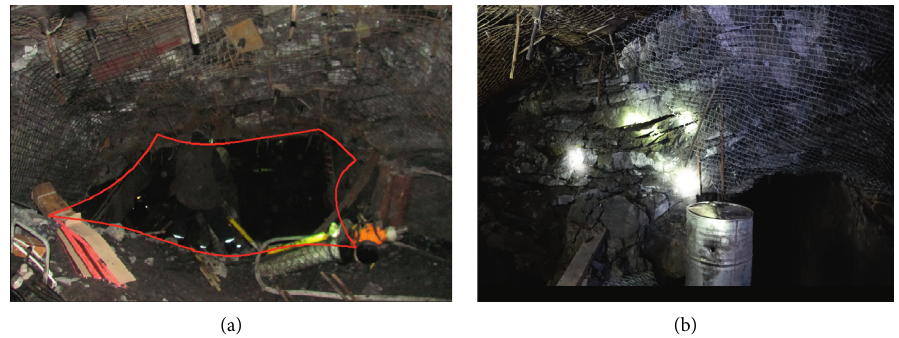
Figure 18: Deformation and failure of roadway surrounding rock. (a) Deformation and failure. (b) Layered joints.